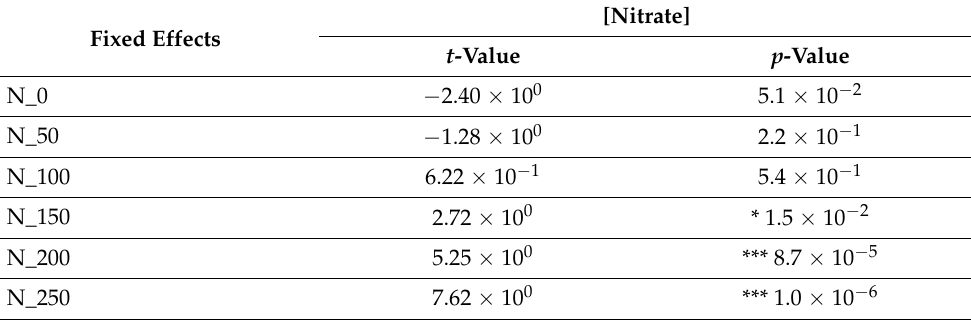
Table 7. Fixed effect results and significance in the estimation of the nitrate content ([Nitrate]) in spinach leaves subjected to different N fertilization (0, 50, 100, 150, 200, and 250 kg N ha − 1 : N_0, N_50, N_100, N_150, N_200, and N_250, respectively). Significance codes: p -value < 0.001 ***, p -value < 0.05